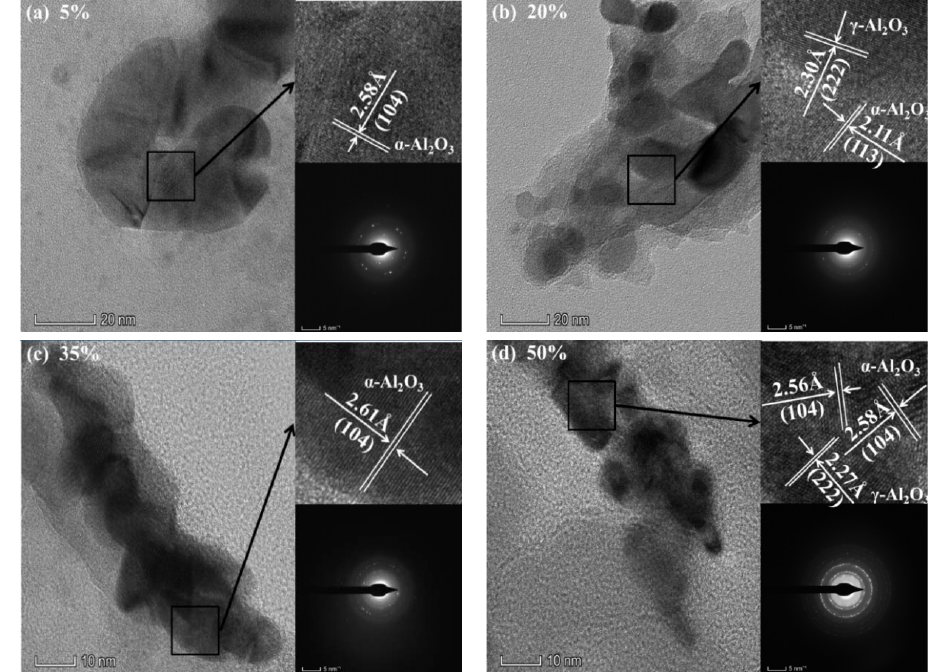
Figure 6. The micro-morphology and electron diffraction patterns of CPED coatings.